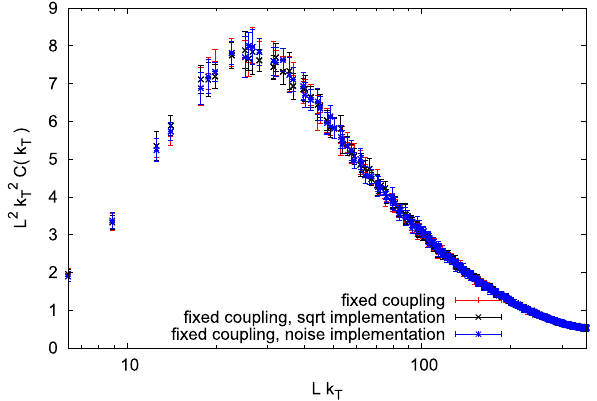
Fig. 11 Consistencycheckoftheimplementationofcouplingprescrip- tions: the fixed coupling constant evolution at rapidity s = 0 . 08 is com- pared with the results obtained with running coupling constant with the running switched off. Agreement of the curves shows that although dif- ferent implementations are used, all normalization factors are correctly taken into